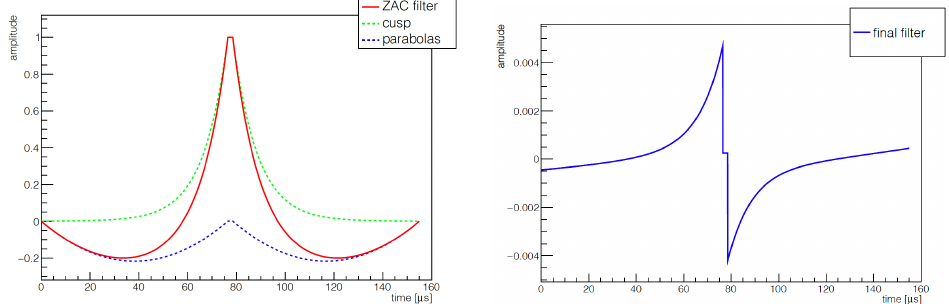
Figure 17. Left panel: ZAC filter construction, finite-length cusp (green dashed line) and two negative parabolas (blue dashed line) are summed to obtain the ZAC filter (red full line). Right panel: ZAC filter after the convolution with the inverse pre-amplifier response function